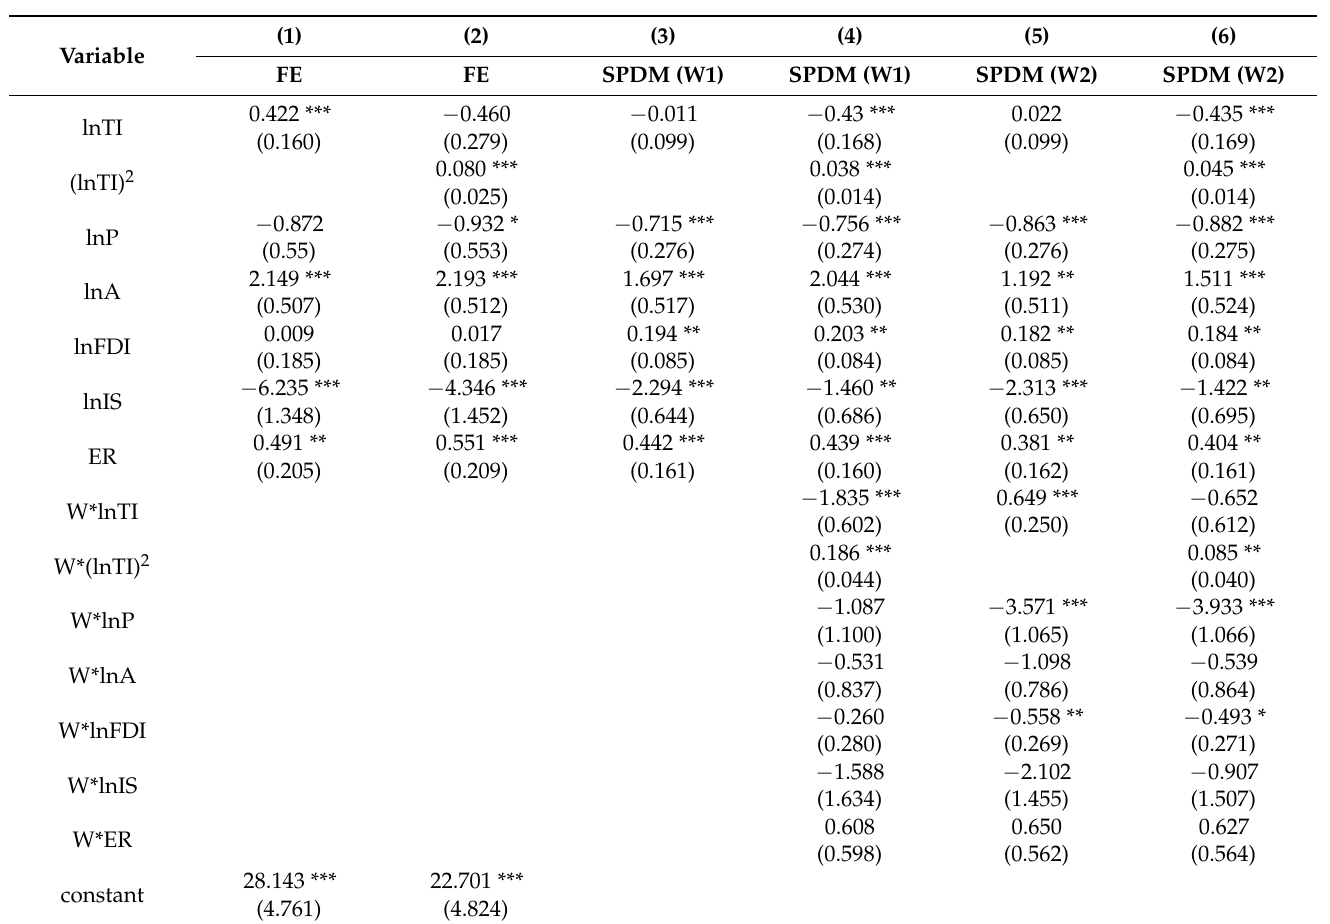
Table 4. Overall regression